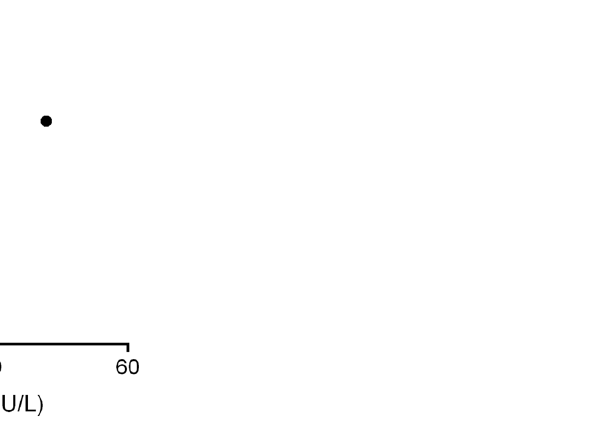
Figure 5. Correlation between insulin concentration in serum and insulin concentration in serum dialysate, measured with